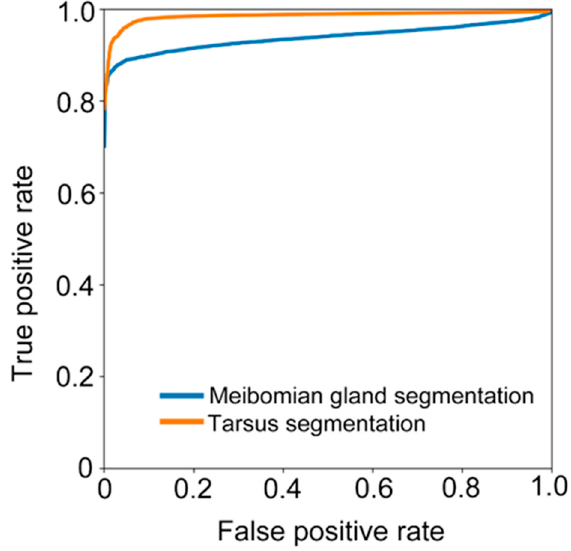
Figure 6. The receiver operative characteristic (ROC) curves for the models segmenting the tarsus and meibomian gland area.